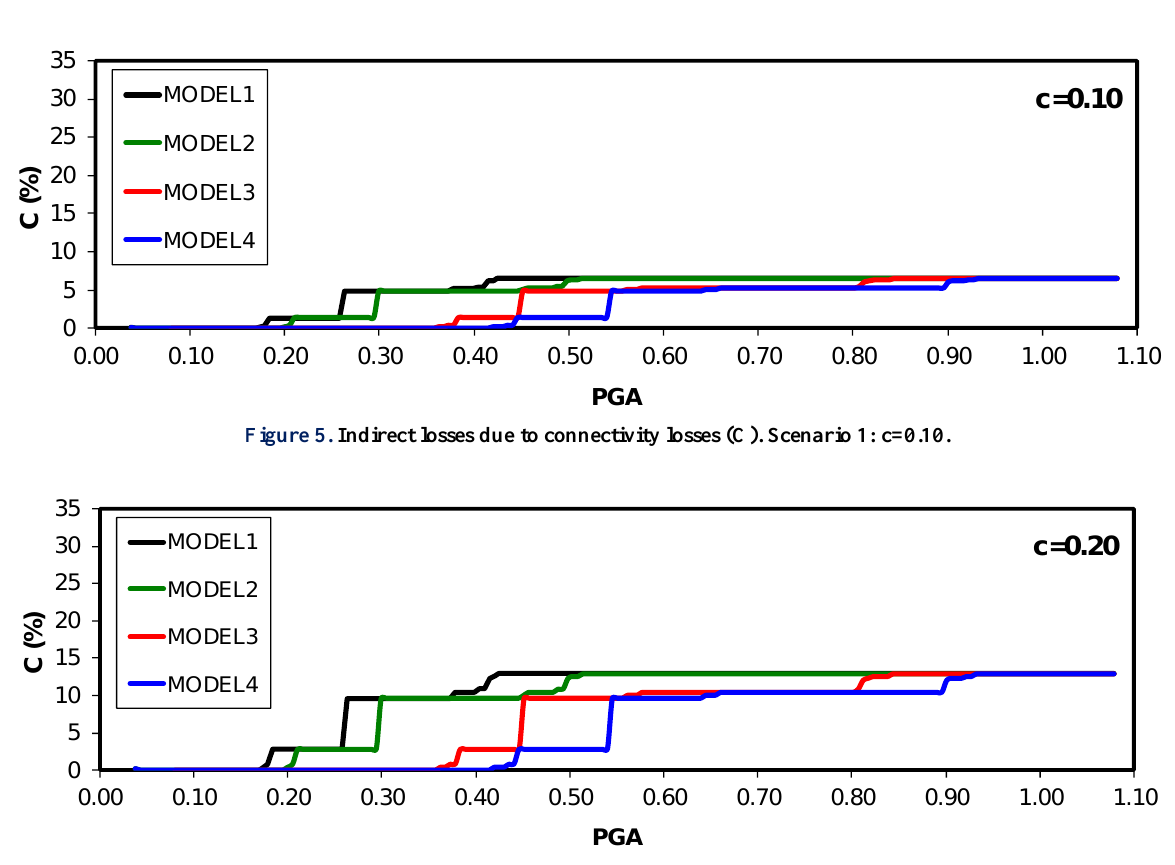
Figure 6. Indirect losses due to connectivity losses (C). Scenario 2: